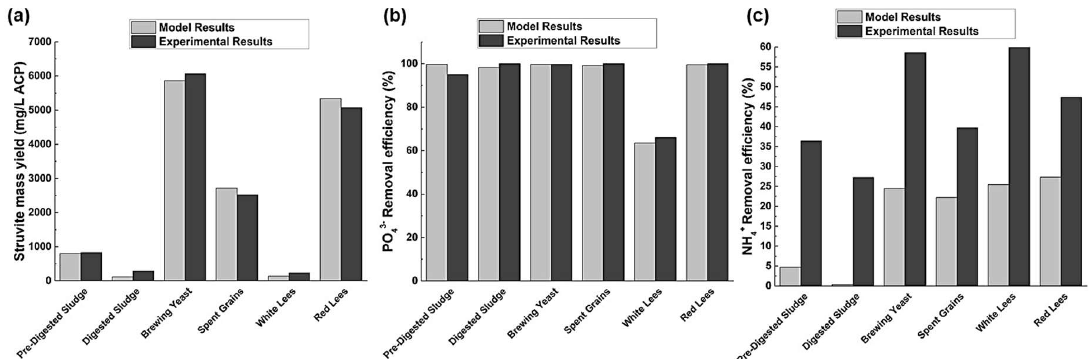
Figure 1. Theoretical and experimental mass yield of struvite ( a ) and removal efficiency of ( b ) orthophosphate (PO 43− ) and ( c ) ammonium (NH 4+ ) from post-HTL ACP of select waste feedstocks via precipitation of struvite.